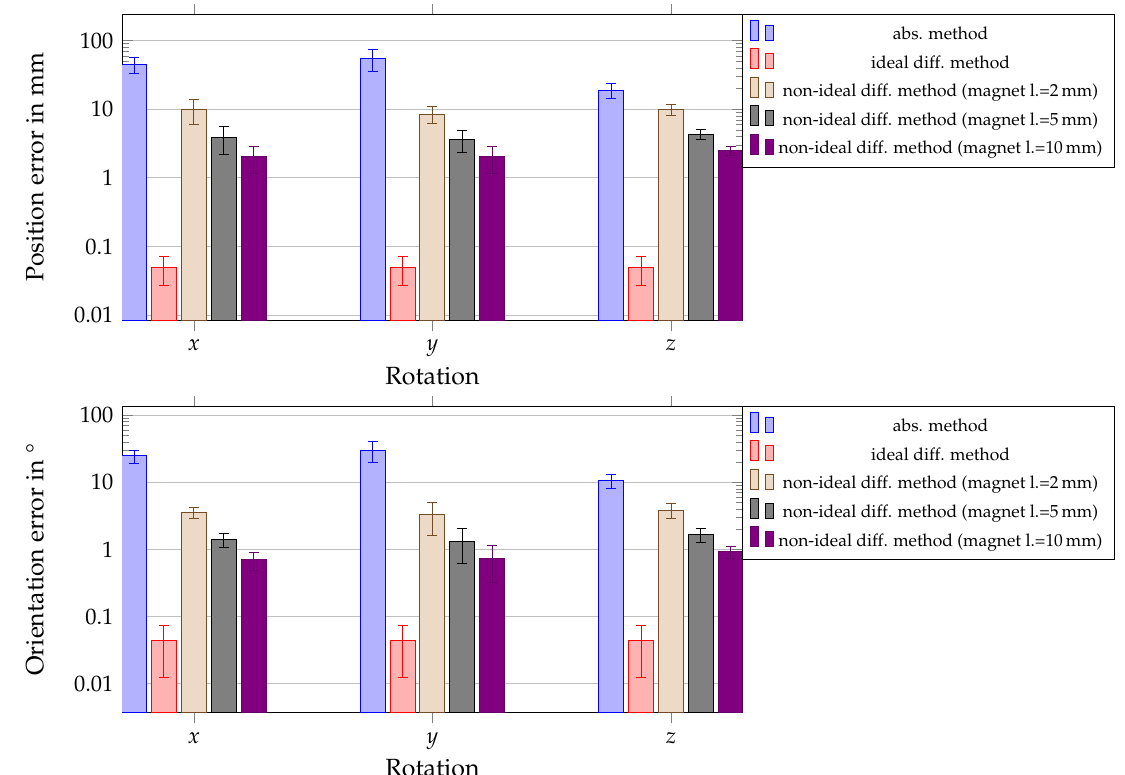
Figure 14. Comparison of the absolute method and differential method by applying displacement, misalignment, and RMS-noise for rotations of the system around the − x -, − y - and − z -axes and for different sizes of